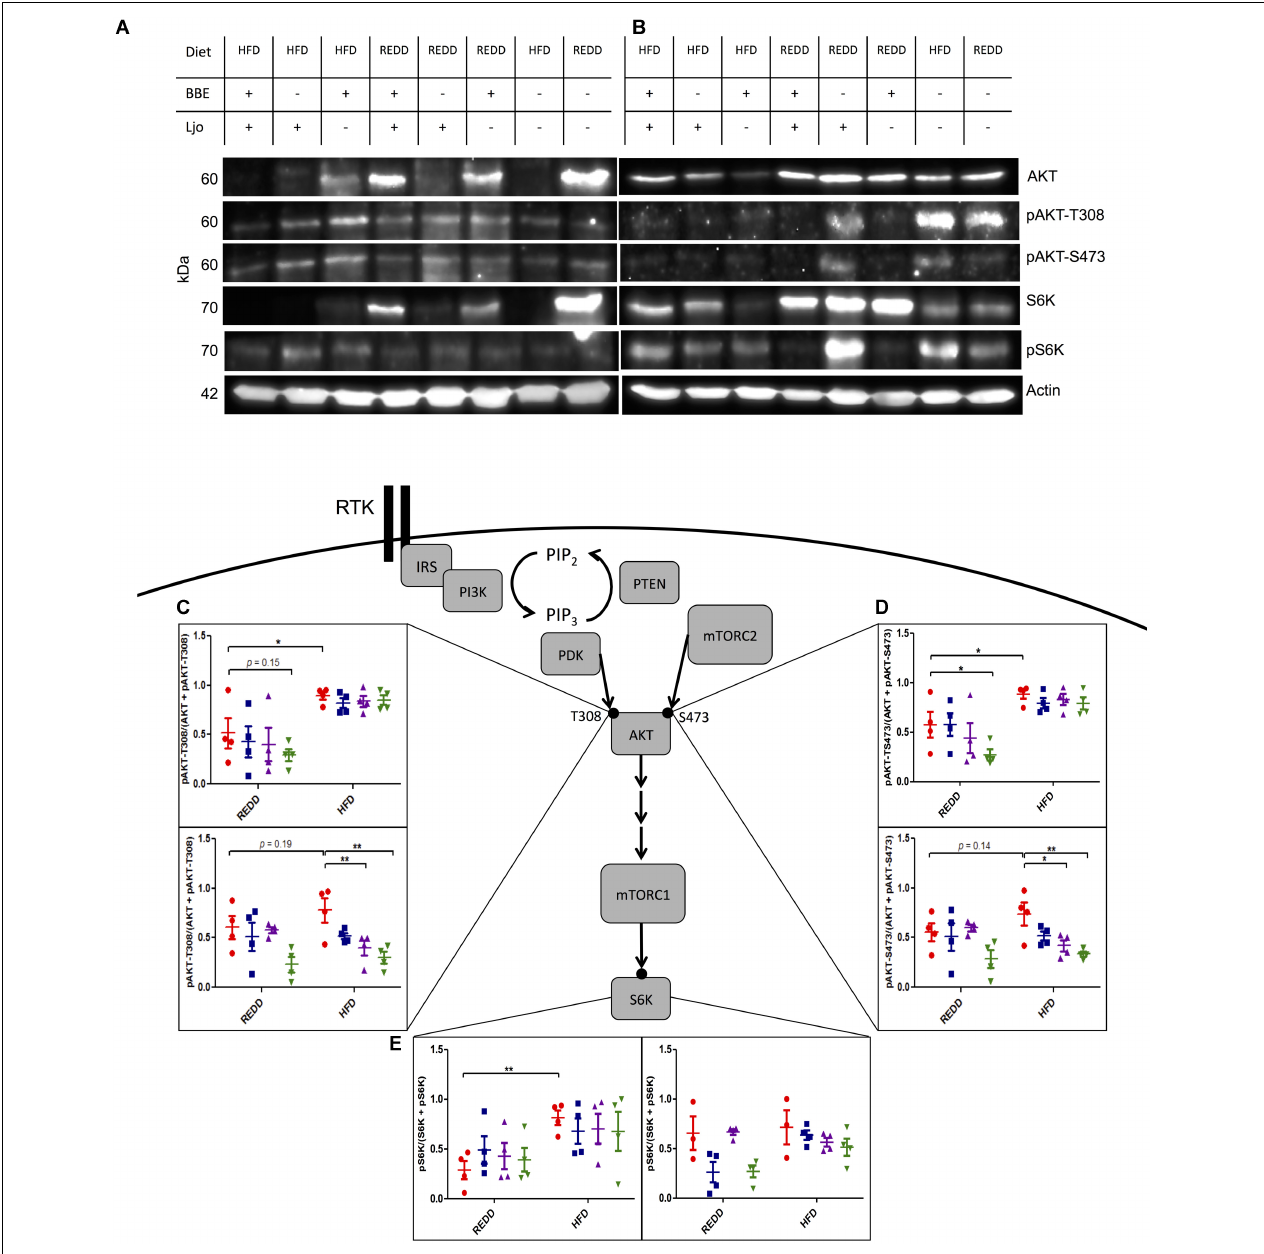
FIGURE 5 | Treatments effect mTORC1 activation in the stomach. Representative Western blot of the pattern observed in REDD and HFD treated (A) males and (B) females comparing the expression of the mTORC1 pathway in the stomach. Actin was used as an internal control. All samples were run in parallel. Images were minimally adjusted in contrast and brightness. Relative quantification of (C) pAKT-T308 for male (top) and female (bottom), (D) pAKT-S473 for male (top) and female (bottom), and (E) pS6K for male (left) and female (right) by densitometry analysis of Western blots. Proteins were extracted by homogenizing tissue in RIPA buffer. A Bradford curve using BSA as a standard was used for protein quantification and 30 µ g of protein was separated on a 12.5% SDS-PAGE gel. Actin was used an as internal standard to ensure consistent loading and to normalize all samples. ImageJ was used to quantify intensity of bands. Phosphorylation levels were calculated by dividing the phosphorylation by the unphosphorylated and the phosphorylated form of the protein. Numerical data are summarized as means ± SEM. ∗ p < 0.05, ∗∗ p < 0.01. Red circle, control; blue square, blueberry extract; purple triangle, L. johnsonii ; green triangle, blueberry extract + L. johnsonii . REDD, reduced energy density diet; HFD, high fat diet; BBE, blueberry extract; Ljo, L. johnsonii .